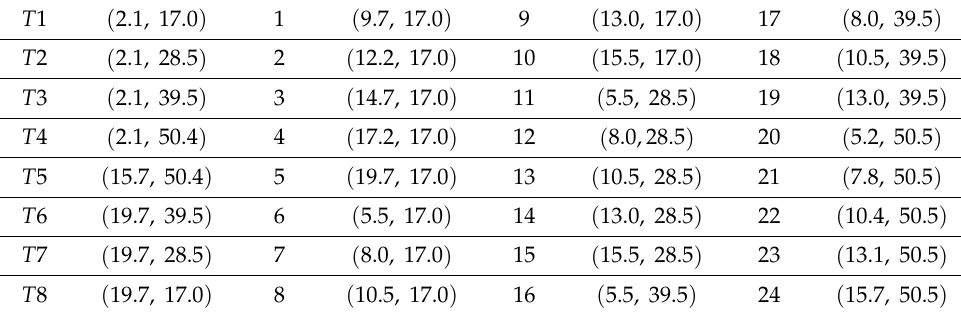
Table 1. Coordinates in metric units of all nodes in test